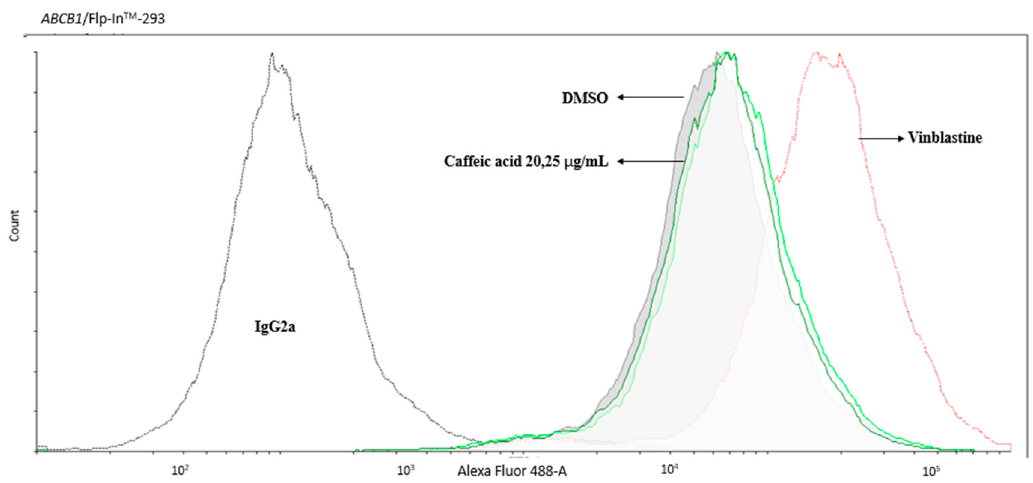
Figure 2. The result of MDR1 shift assay. The conformation of P-gp was not influenced under the treatment of 20 and 25 μ g/mL caffeic acid. Vinblastine (a standard substrate of P-gp) was used as a positive control.